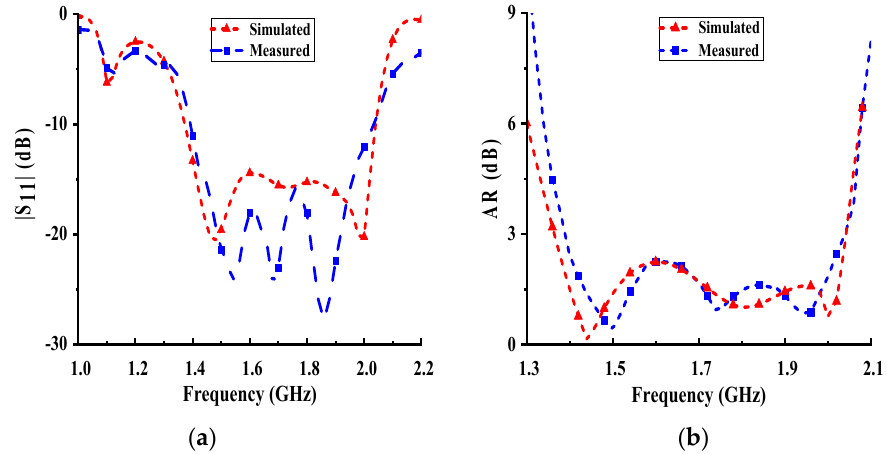
Figure 7. Simulated and measured results. ( a ) Reflection coefficient. ( b ) AR.